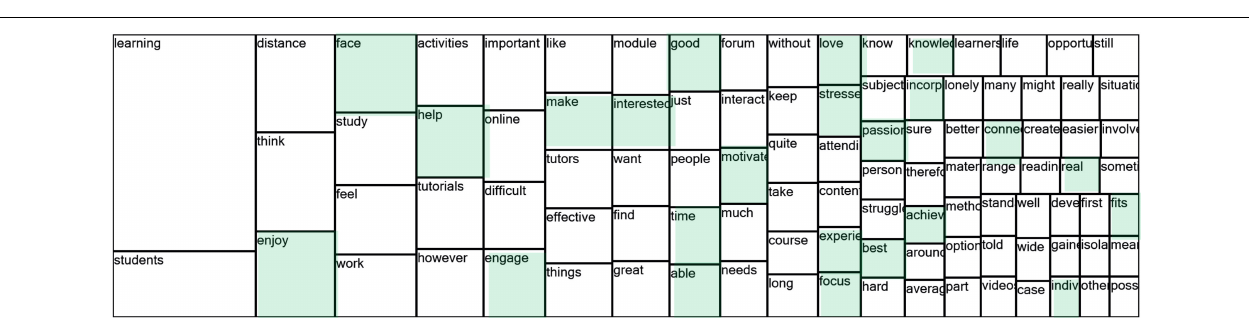
FIGURE 6 | Sentiment analysis about students’ positive views related to Online Learning and